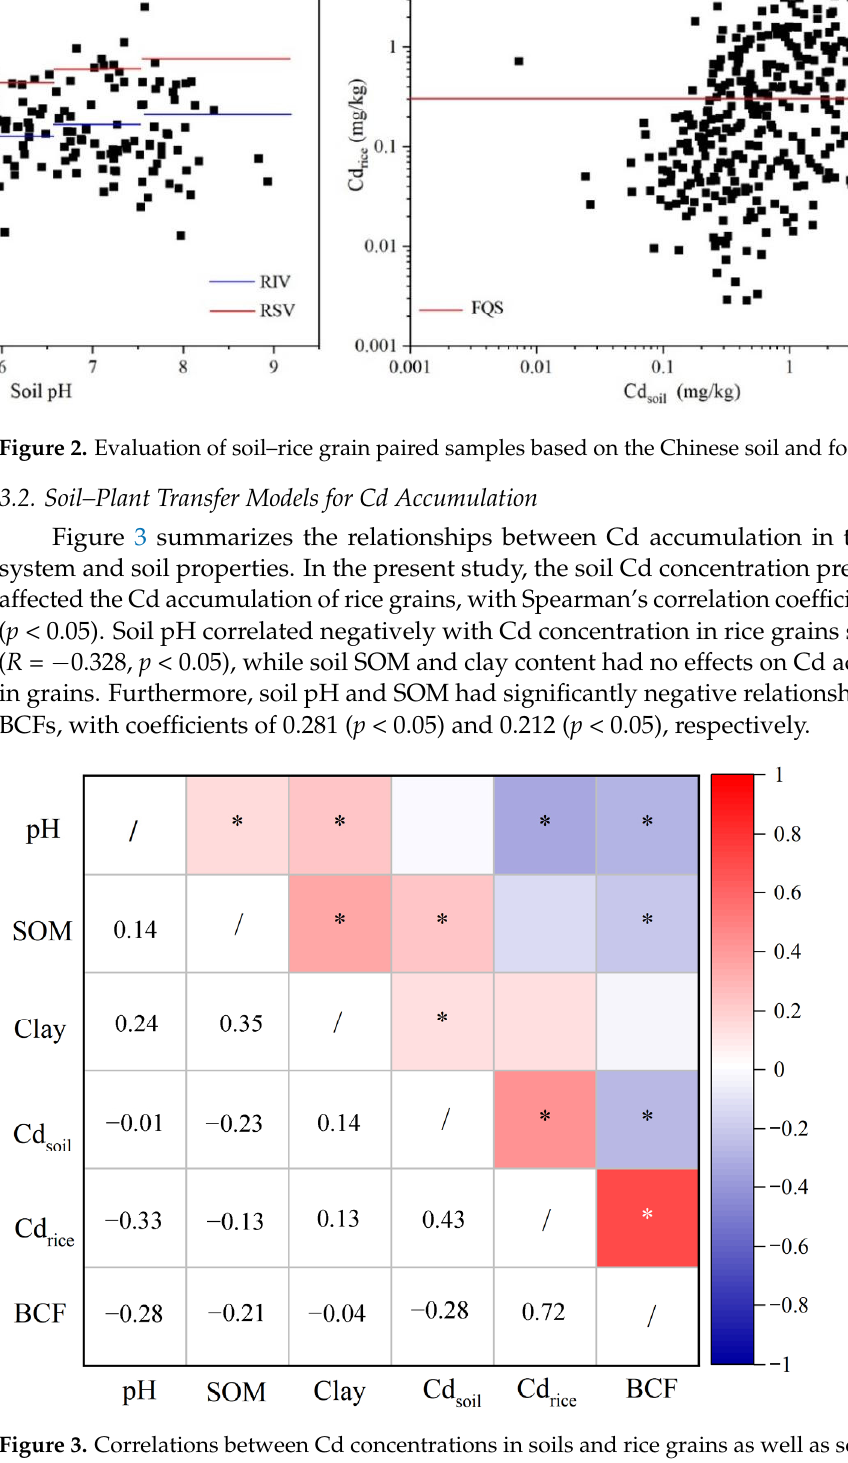
Figure 3. Correlations between Cd concentrations in soils and rice grains as well as soil properties. The color of red and blue indicate positive and negative relationships, respectively. * denotes significant correlation at p < 0.05.